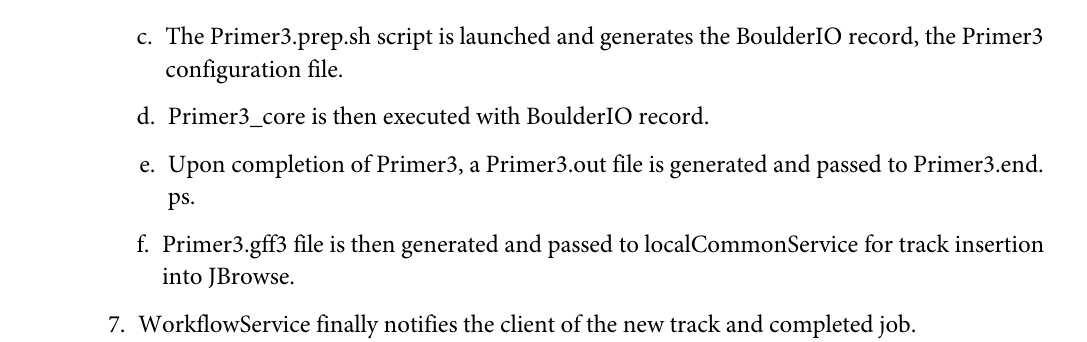
Fig 8. The JBConnect server architecture encompasses plugins (including JBPrimer3, JBAnalyze, JBClient), various Models (including Job, Service, Track, & Dataset), any number of Job Services, and various utility modules.